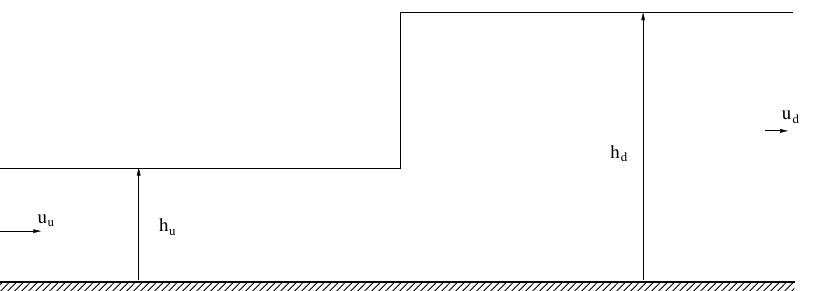
Figure 2. Schematic view of the hydraulic jump. The meaning of the variables is described in the text. The corresponding flow is described by a depth h u and velocity u u upstream of the jump, and a depth h d and velocity u d downstream of the jump. The following values have been chosen for the present case: h u = 0.7 m, u u = 6.7 m/s, h d = 2.2 m and u d = 2.1 m/s. Note that these values satisfy Equations (1) and (2). Also note that g = 9.81 m/s 2 . The upstream and downstream Froude numbers are found to be 2.55 and 0.46, respectively. The rate of energy loss in the jump is calculated from Equation (3)